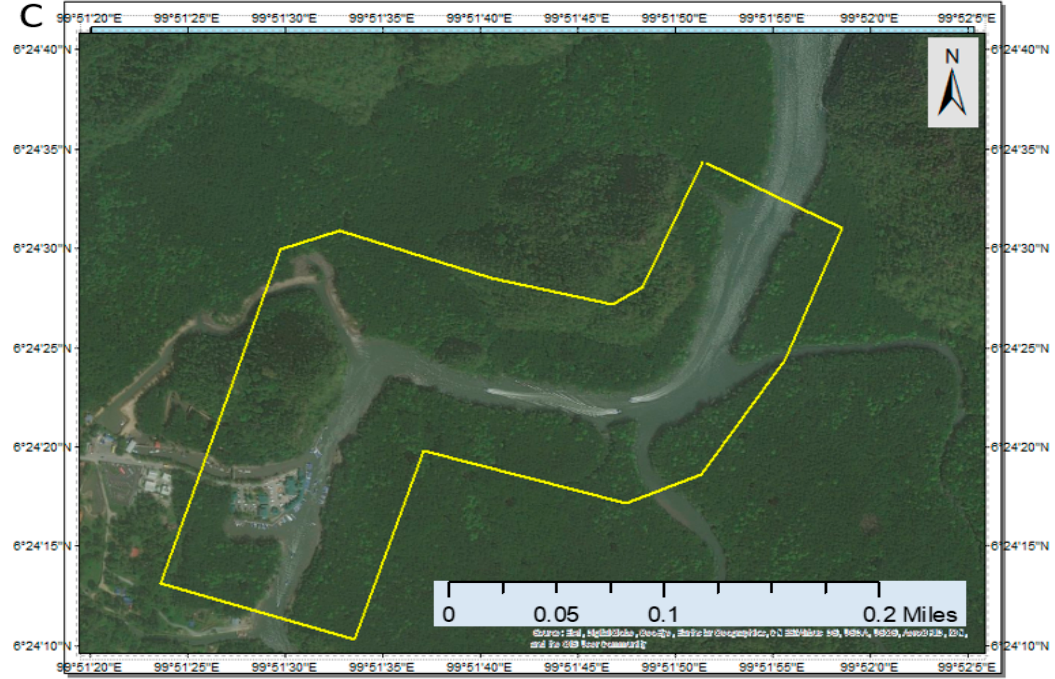
Figure 1. Location of the study area; ( A ) Location of the study area on a map of Peninsular Malaysia; ( B ) Location of the study area on Langkawi Island; ( C ) Location of the study area on the Kilim River. 3. Materials and Methods.